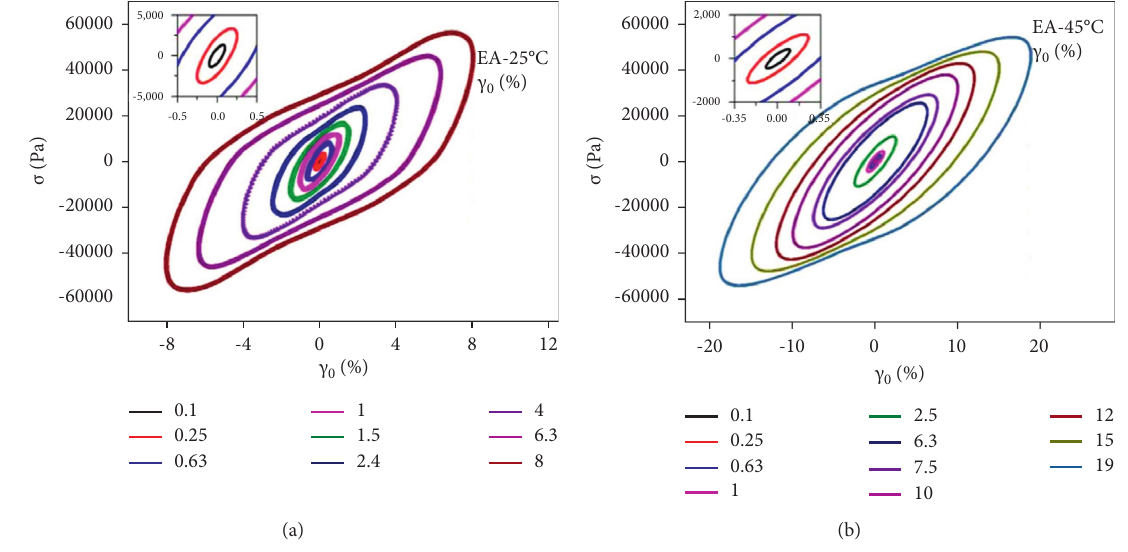
Figure 25: Lissajous curves for EA at angular frequency ω � 6.3rad/s for 25 ° C (a) and 45 ° C (b)